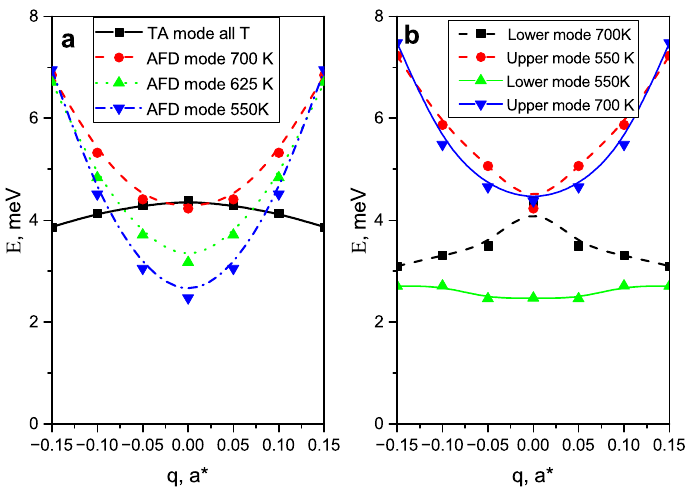
Figure 3. ( a )—Dispersion curves of the “bare” TA and AFD modes. Black squares and solid black line—temperature independend TA mode; red circles dashed line—AFD mode 700 K, green triangles, dashed line—AFD mode 625 K; blue triangles dash dotted line—AFD mode 550 K. ( b )—dispersion of the renormalized modes—color and line types are shown on the